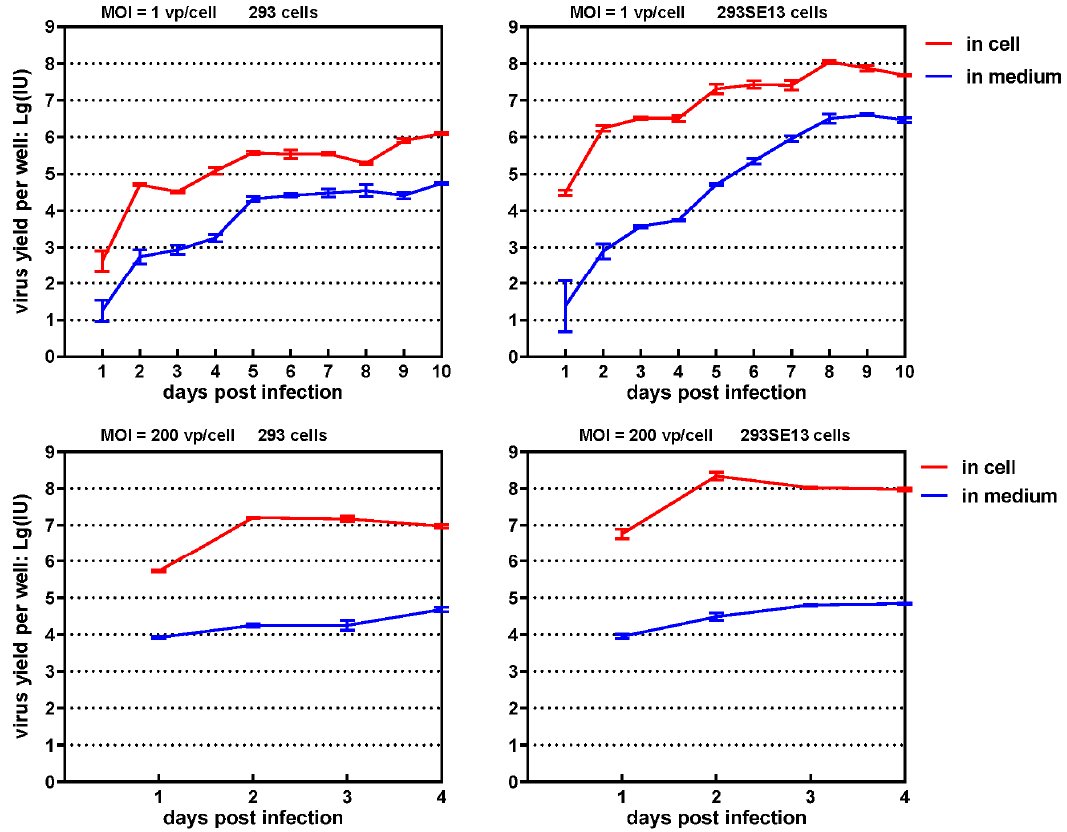
Figure 5. One-step growth curves of SAdV1-EG in 293 or 293SE13 cells. Cells were seeded in 12-well plates and infected with purified SAdV1-EG at an MOI of 1 or 200 vp/cell for 2 h. Cells and the culture media were collected separately at indicated time points post infection. After titration, the yields in each well were calculated and used to construct the growth